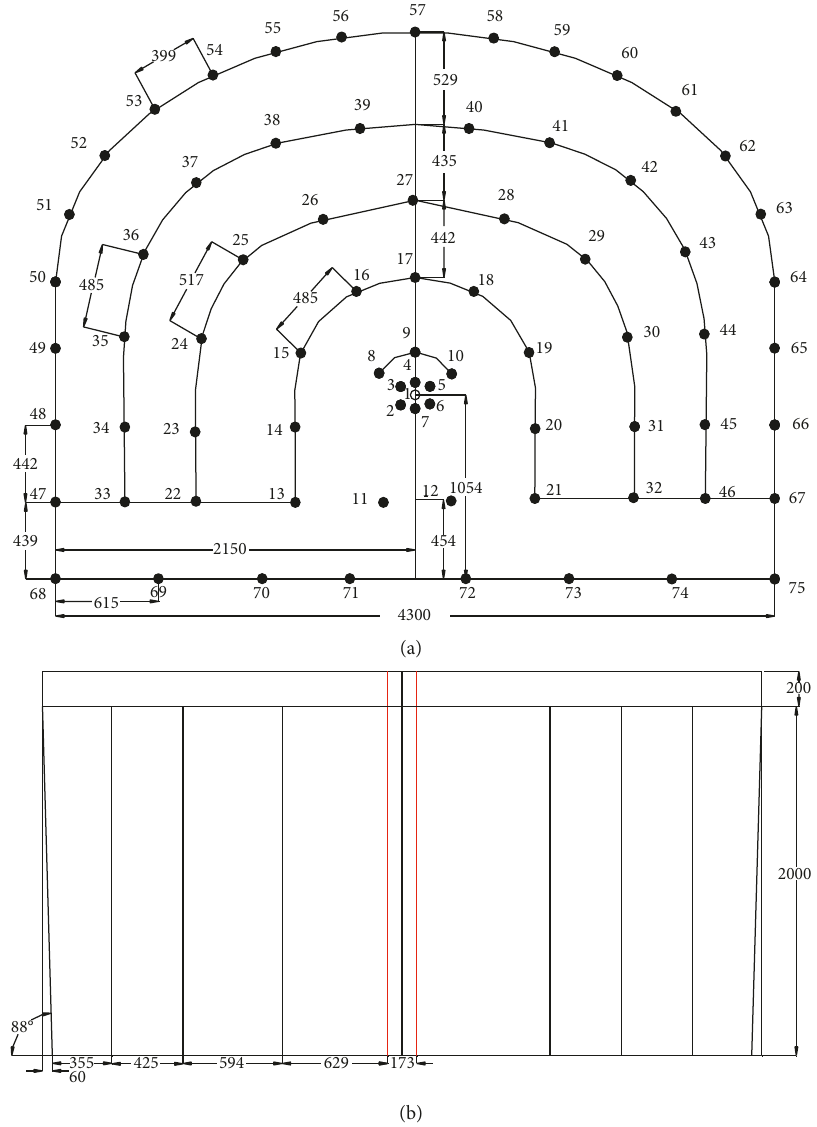
Figure 3: Blasting scheme of parallel hole cutting (unit: